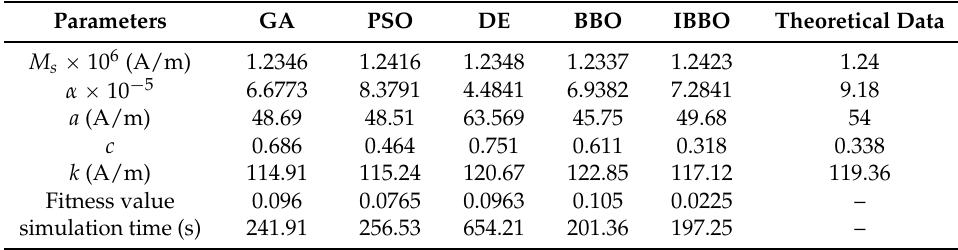
Table 2. Identification results of fixed